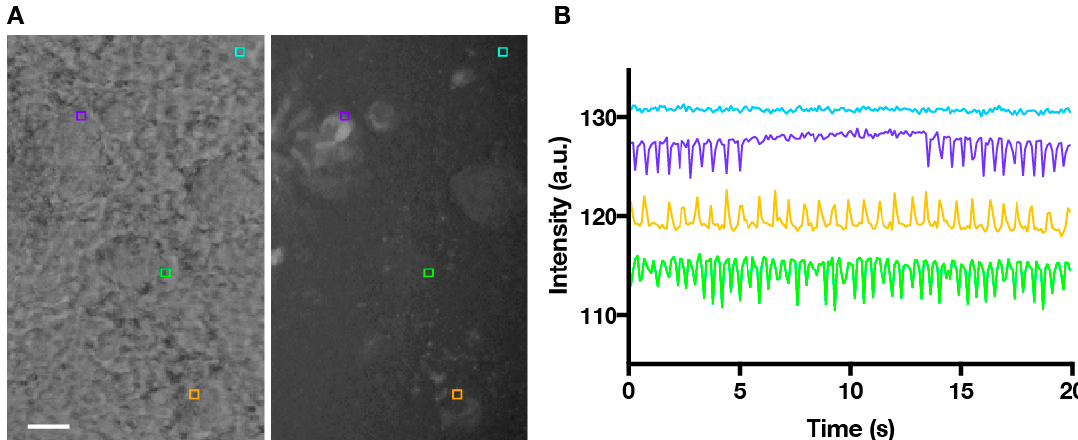
Figure 1. Time-lapse series of beating cardiomyocytes with ROIs (region of interest) placed to extract motion. ( A ) Phase-contrast image of beating areas within an EB (embryoid bodies), and corresponding MHC α ::GFP image confirming cardiomyocyte identity. ROIs (5 × 5 pixels) are placed at the edges of the beating areas (purple, green and orange squares) and a non-beating control area (cyan square). Scale bare = 100 µ m; ( B ) Plot showing changes in the mean pixel intensities within ROIs over time, which correspond to beating motion.